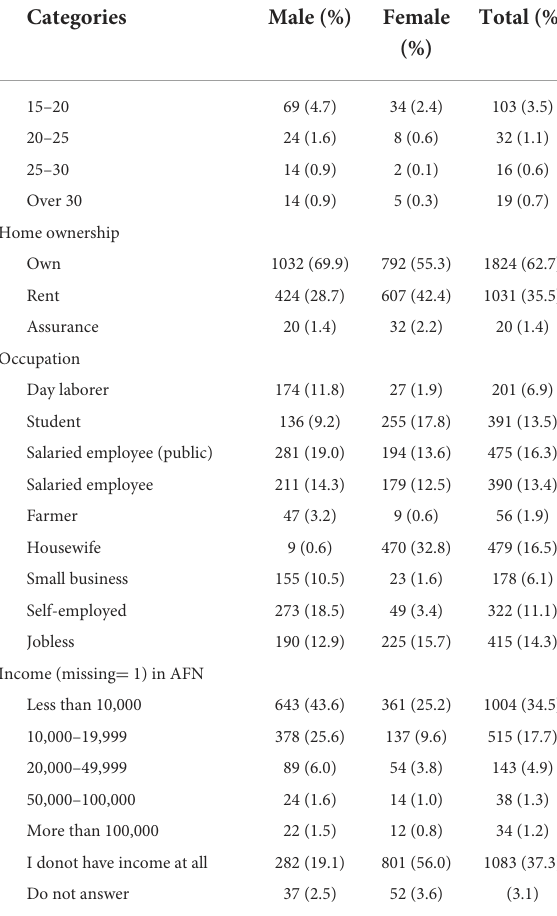
TABLE 1 Frequency distribution of the background characteristics of study participants ( N =